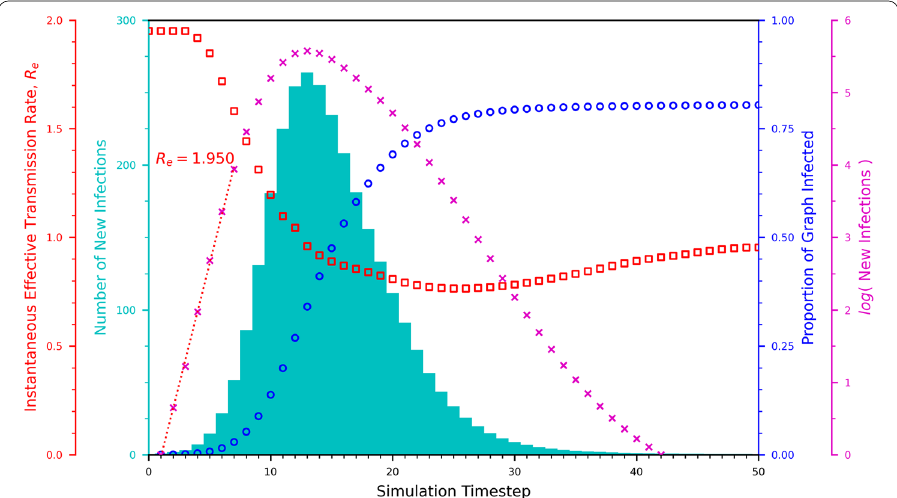
Fig. 1 Aggregated metrics for the spread of an epidemic on the complete airline route graph. The metrics presented are the number of new infections per time-step, the total proportion of the GC that has become infected and the effective transmission rate. The results are the average of 1000 repeats of a random walk, each walk starting at a randomly chosen node. The results exhibit the same characteristics of the well-know SIR compartmental model of epidemic